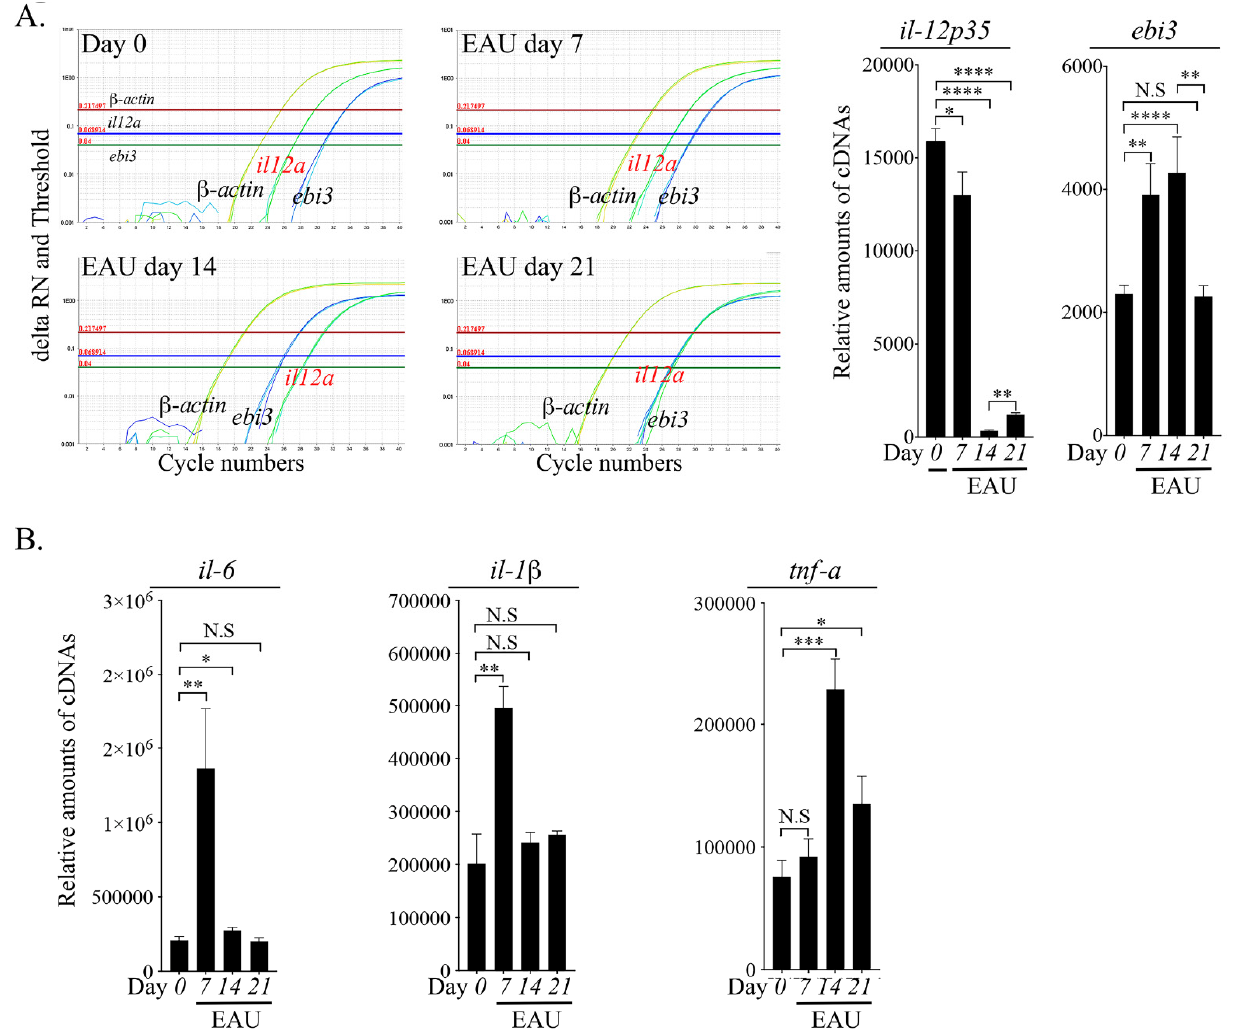
Figure 5. Decrease of IL-35 at EAU onset correlates with increase of inflammatory cytokines. WT C57BL/6J mice were immunized with IRBP 651-670 in CFA, and mice were sacrificed at several